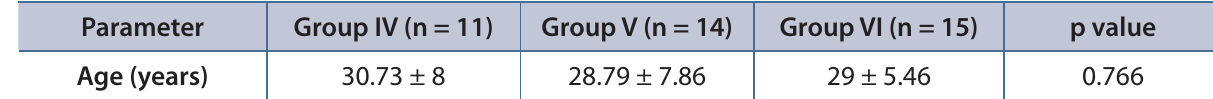
Table 4. Clinical data of hemodialysis